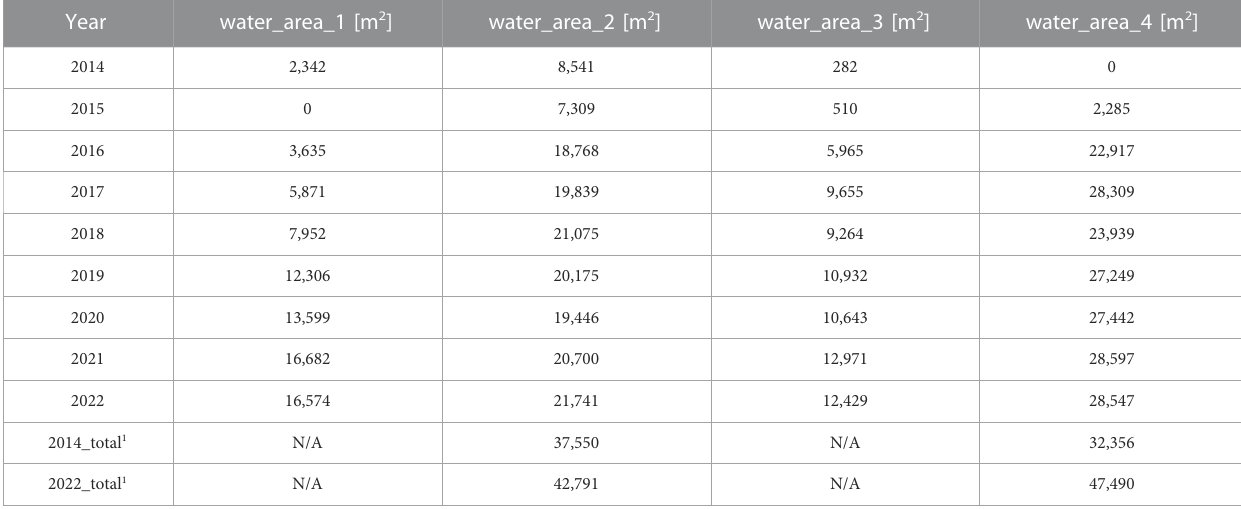
TABLE 2 Water surface area of individual sinkholes in 2014 –